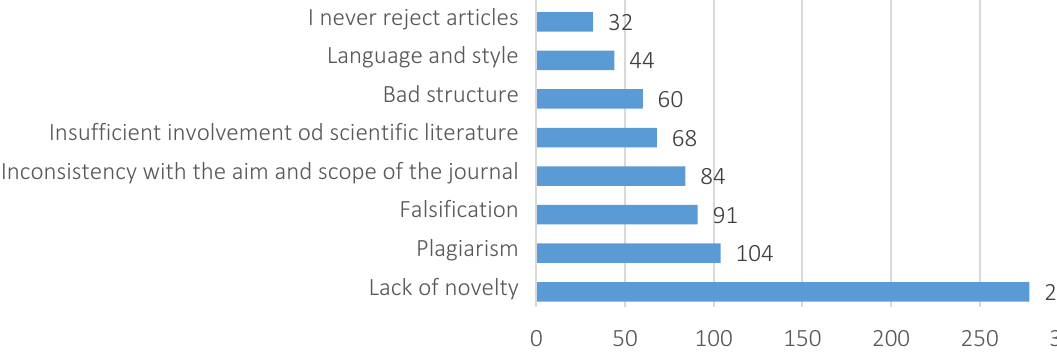
Figure 4. Distribution of answers to the question “For what reasons do you reject articles?”